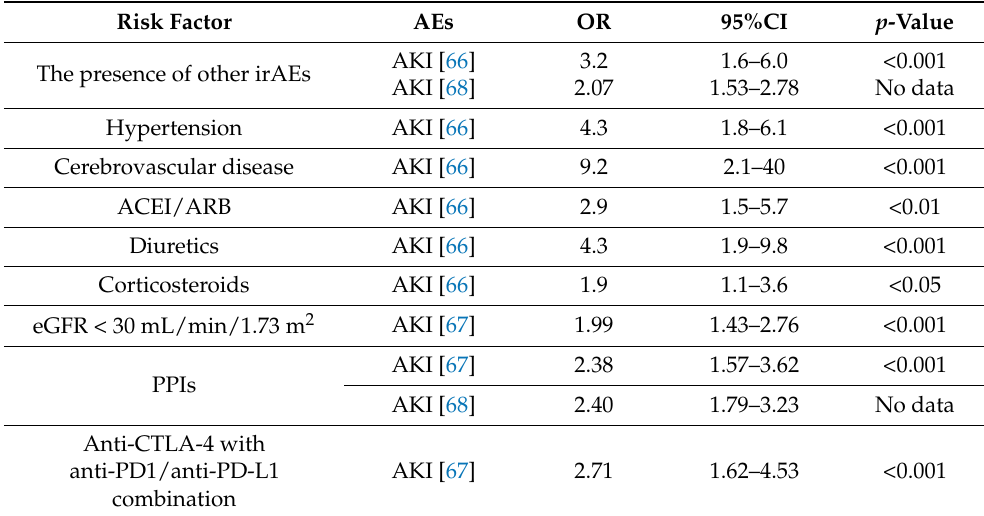
Table 2. Risk factors for the ICI-induced